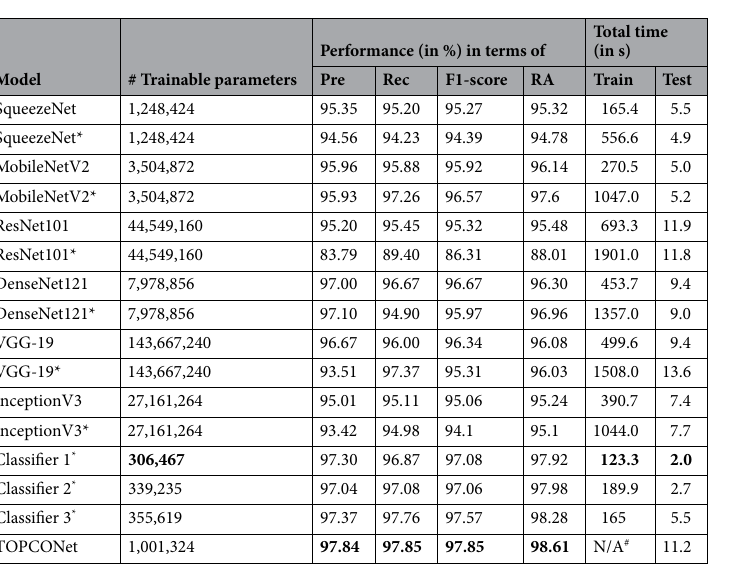
Table 3. Performance comparison of the proposed 3 base classifiers and TOPCONet with some state-of-the- art CNN models utilising the concept of transfer learning and training from scratch on Dataset-2. For citing recall (Rec), precision (Pre) and F1-score micro-average method is used. *After the CNN models’ name means that the models have been trained from scratch. # As the proposed ensemble method is non trainable, hence time required to run on the training split is not applicable (N/A). RA indicates recognition accuracy and bold faced numbers indicate the best